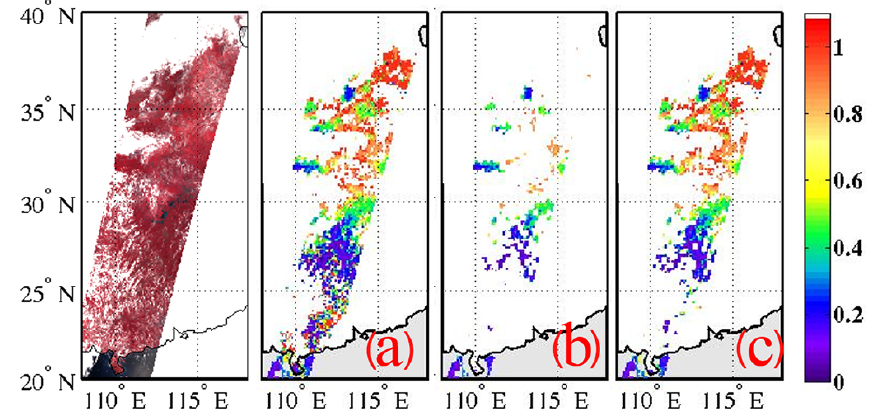
Figure 4. Example of a retrieval scene over China, for the overpass on 18 August 2010: false-colour RGB image for nadir view (left), L2 AOD retrieved with ADV/ASV (a) , after the application of ExCPP (b) and after the application of the ImCPP (c) described in Sect. 3.2.